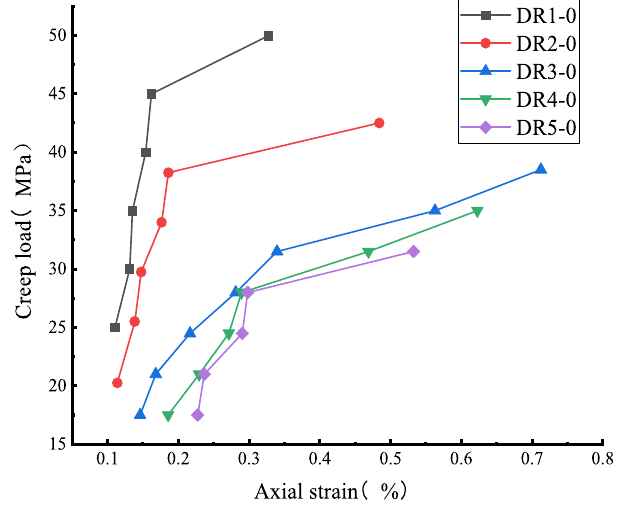
Figure 12. Relationship between steady state creep rate and creep stress.